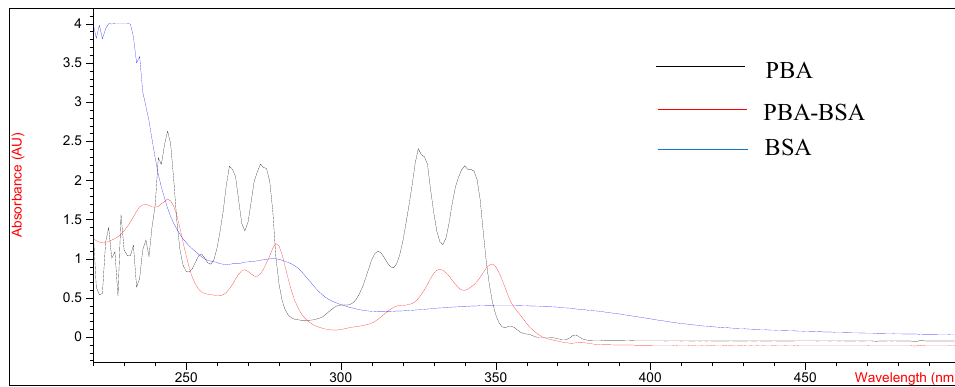
Figure 1. UV spectrum of BSA, PBA and PBA-BSA.